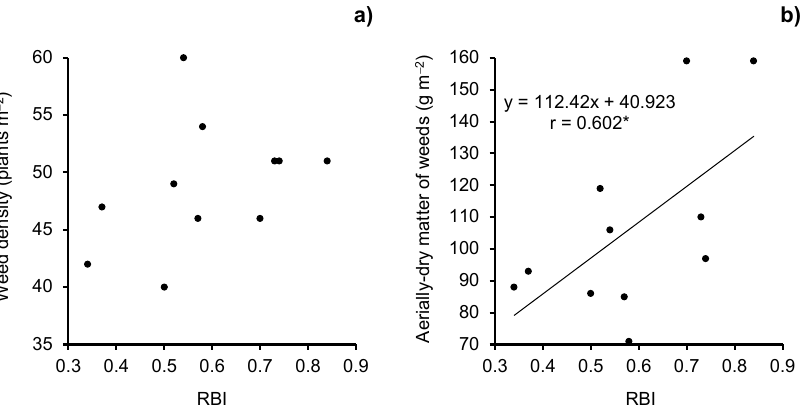
Fig. 2. The linear relationship between RBI of triticale-lupin mixture and a) weed density and b) aerially- dry matter of weeds at the harvest. Regression equation with line and Pearson correlation coefficient (r), is shown when r is significant (* – at 0.05 probability level, n=11). The points represent treatment means of untransformed data averaged over 2015–2017.